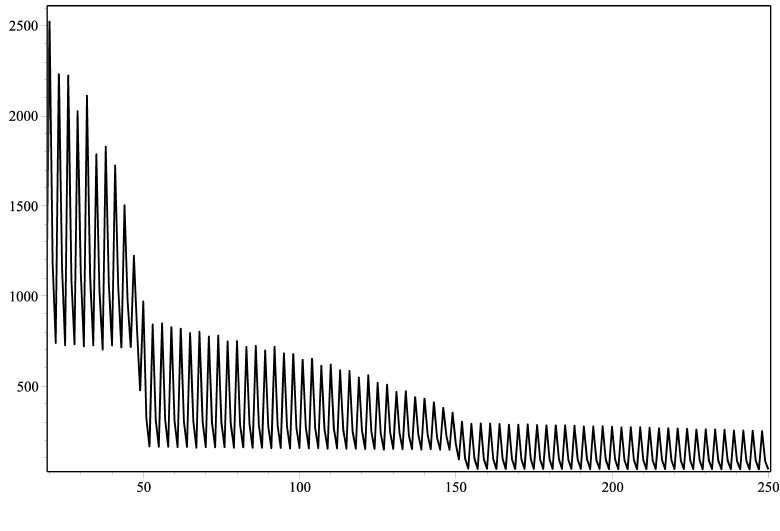
Fig. 3. Graph of σ 3 ( d ) for 20 ≤ d ≤ 250